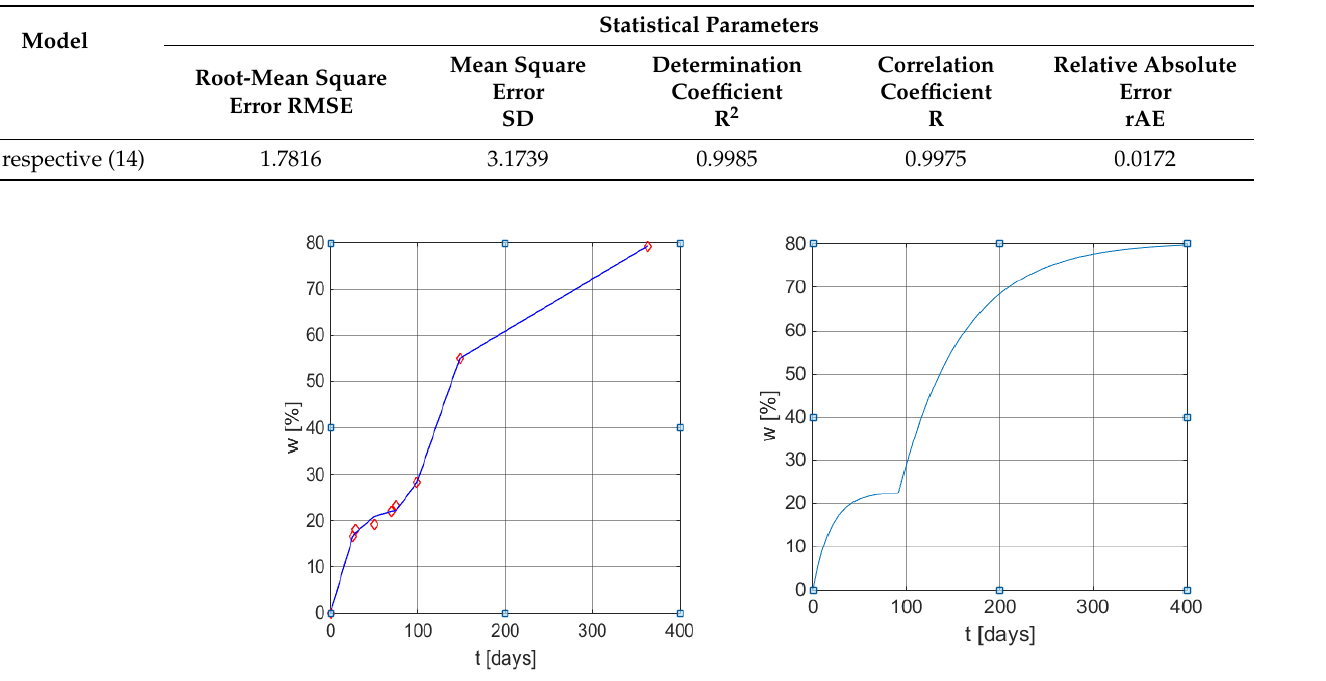
Figure 5. Graphical results of the weight loss profile obtained using the mathematical models (6) and (9). Left: measured values vs. values obtained from Equation (14) with MATLAB function plot . Right: w ( t ) curve using model (9) with the same parameters as in (14). Table 6. Statistical indicators for the accuracy of model (6) in the case of experimental data from [43].